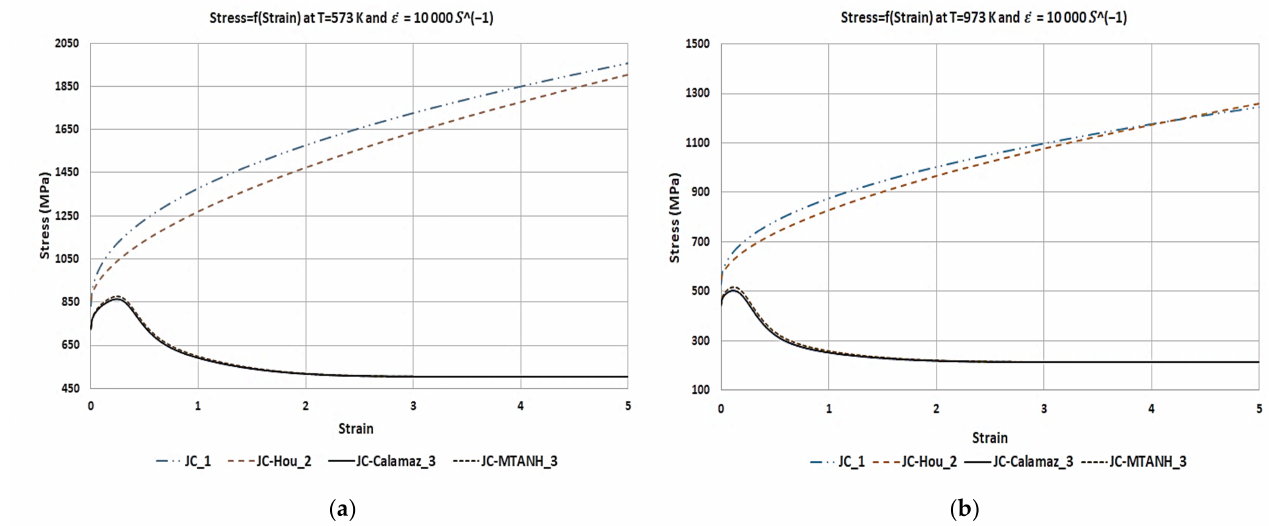
. ε 0 = 10,000 s − 1 and ( b ) at